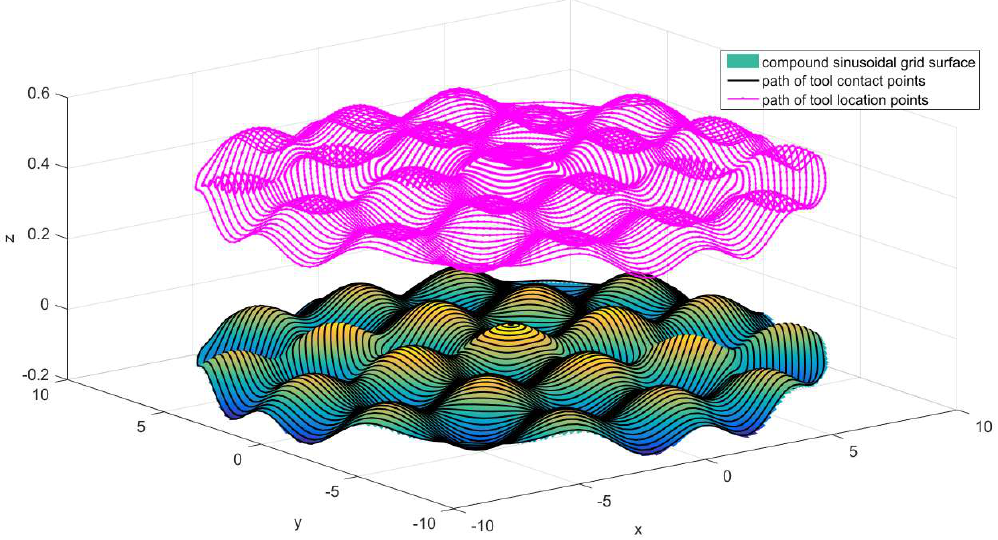
Figure 15. Compensation result of tool nose radius.